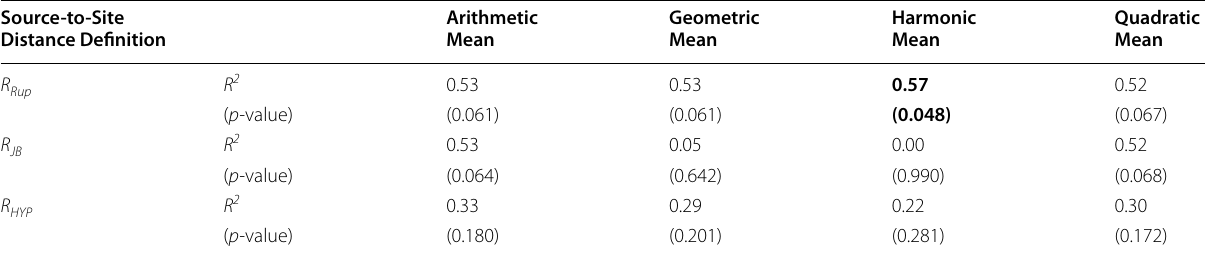
R Bold values represent the mean value that fits well with the available data